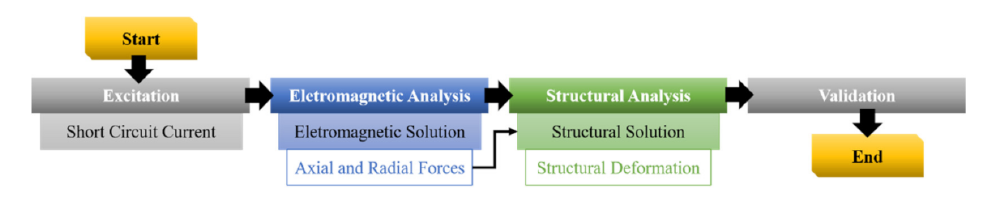
Figure 11. Magneto-structural coupling.